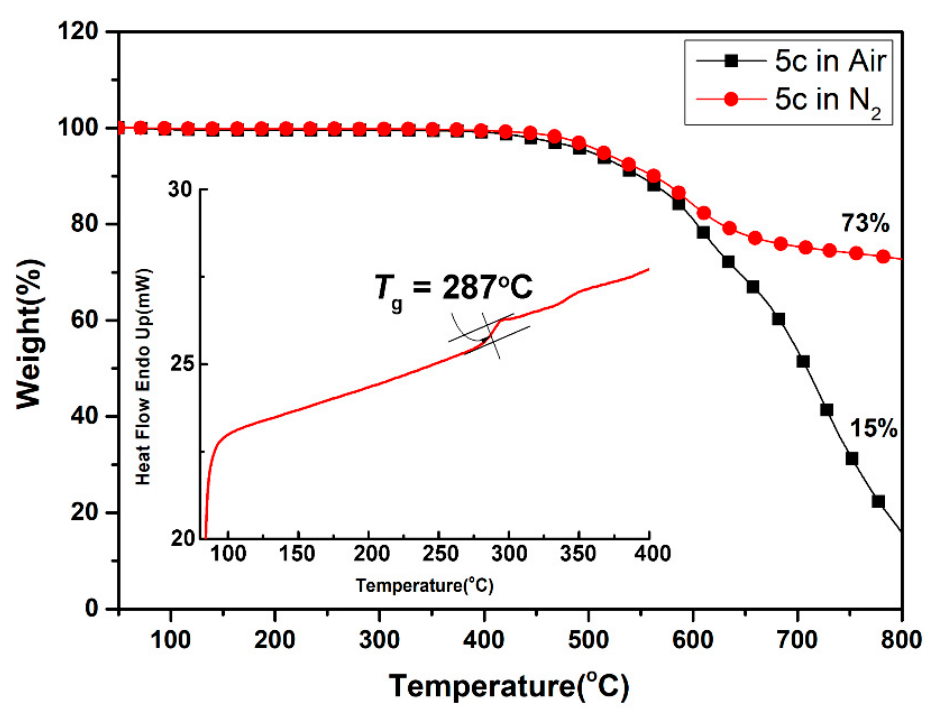
Figure 5. Representative TGA and DSC traces of polyamide 5c .